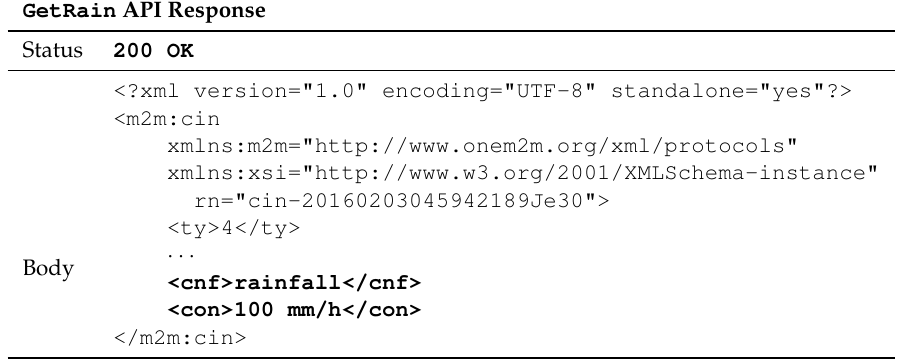
Table 4. An example of the GetRain API response of which the body includes the rainfall value (100 mm/h).